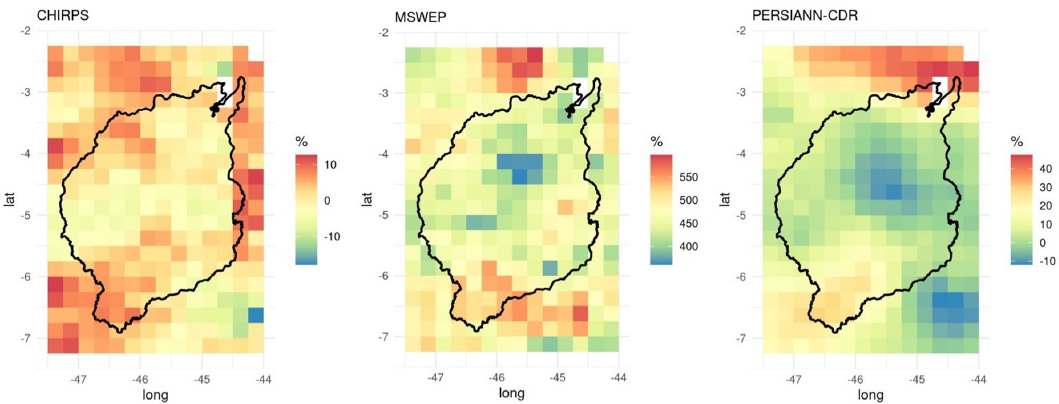
Figure 4. pbias between gridBR and RES products for the total daily mean from 1983 to 2013. Each SRE has different representative scales.